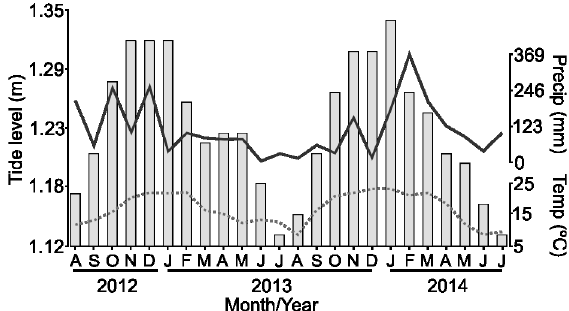
Figure 1. Monthly climatic data recorded during two years of monthly samples in a tidal freshwater wetland from Argentina. Temp: average of the mean daily temperature (dotted line); Precip: cumulative precipitation (solid line); Tide level: average of the daily highest tide